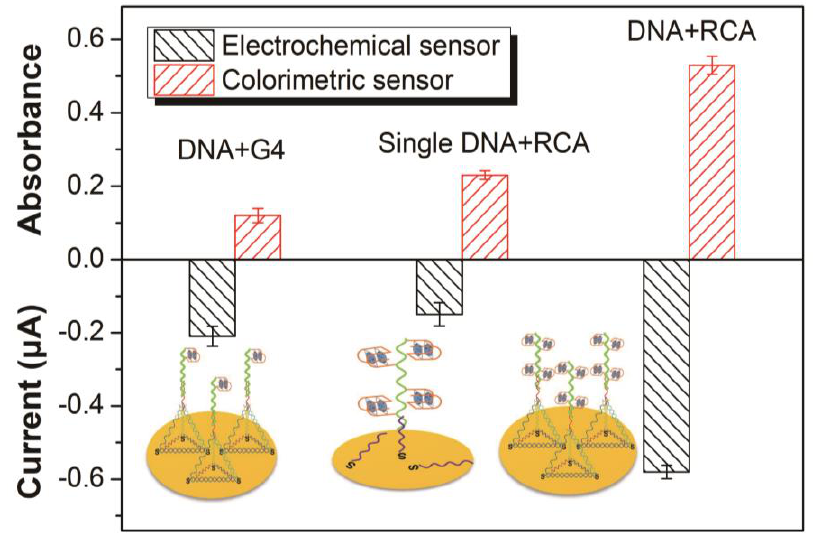
Figure 2. P. aeruginosa analysis results from three different sensors: DNA+G4, Single DNA+RCA, and DNA+RCA. and DNA +